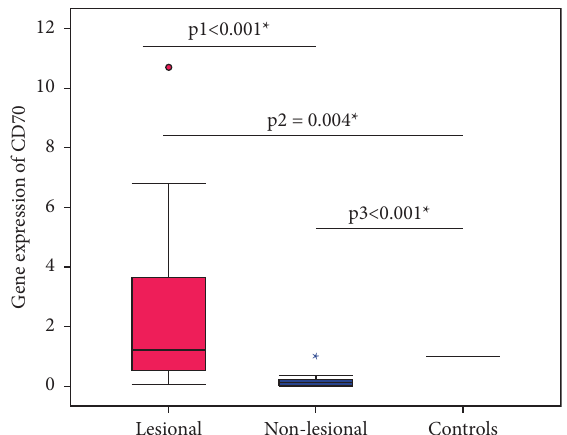
Figure 1: The relative expression of CD70 gene in patients with AA ( n � 40) compared to HCs ( n � 40). The relative CD70 gene expression in AA lesions ranged from 0.07 to 10.70 (mean 2.41 ± 2.71, median 1.22), while in non-lesional areas, it ranged from 0.01 to 0.82 (mean 0.16 ± 0.19, median 0.12). Wilcoxon signed rank test (p1) was used to compare the expression in AA lesions and non-lesional areas.